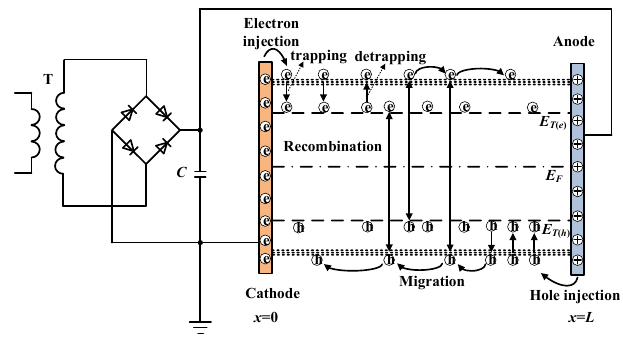
Figure 1. Schematic of the bipolar charge carrier injection and charge carrier transport in polymer nanocomposites under a ramp voltage.